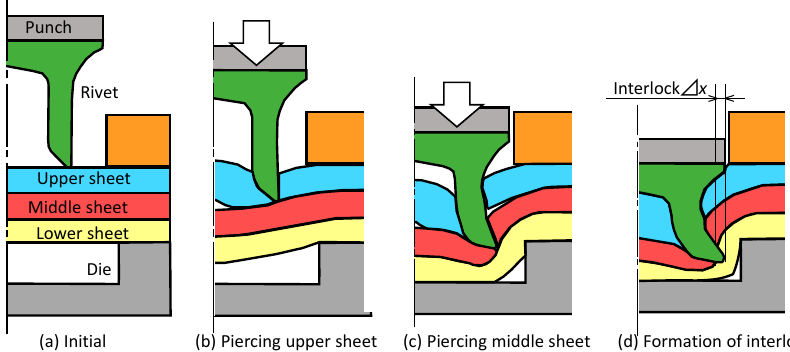
Figure 2. Self-pierce riveting process of three sheets: ( a ) initial; ( b ) piercing upper sheet; ( c ) piercing middle sheet; ( d ) formation of interlock.